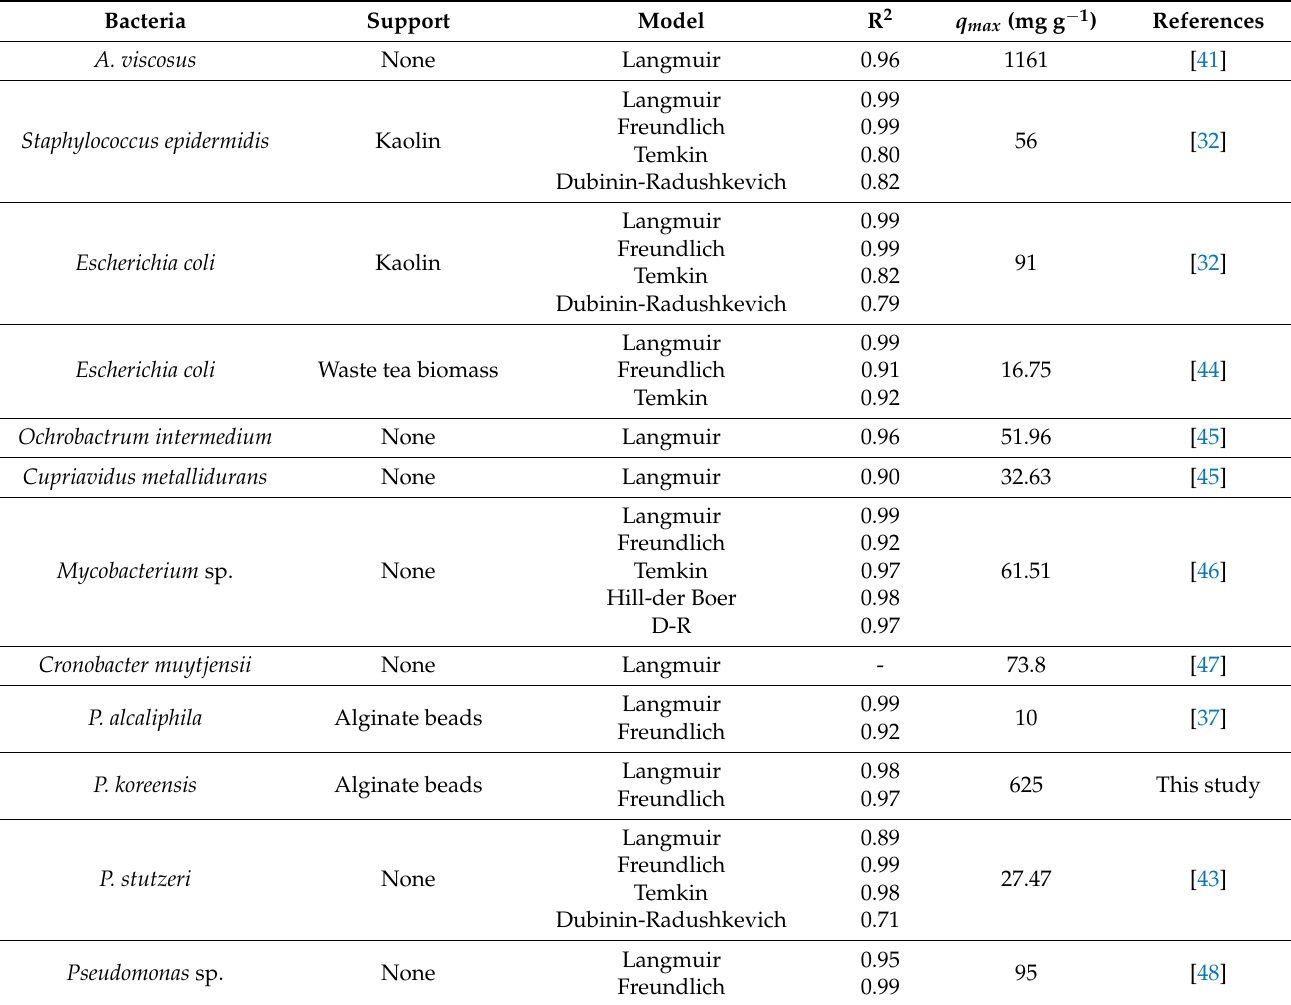
Table 5. Remotion of Cr(VI) by different bacteria.